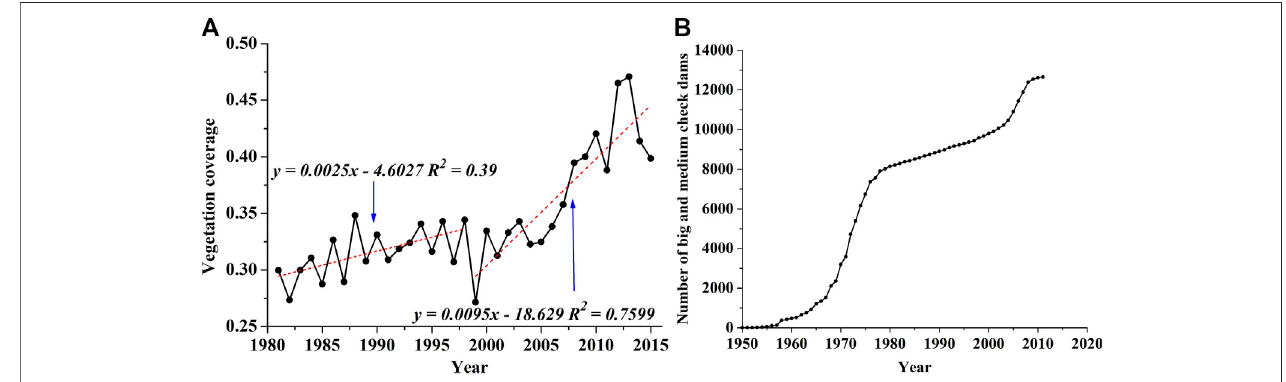
FIGURE 2 | Variations in (A) vegetation coverage and (B) number of check dams in the Hekou-Longmen